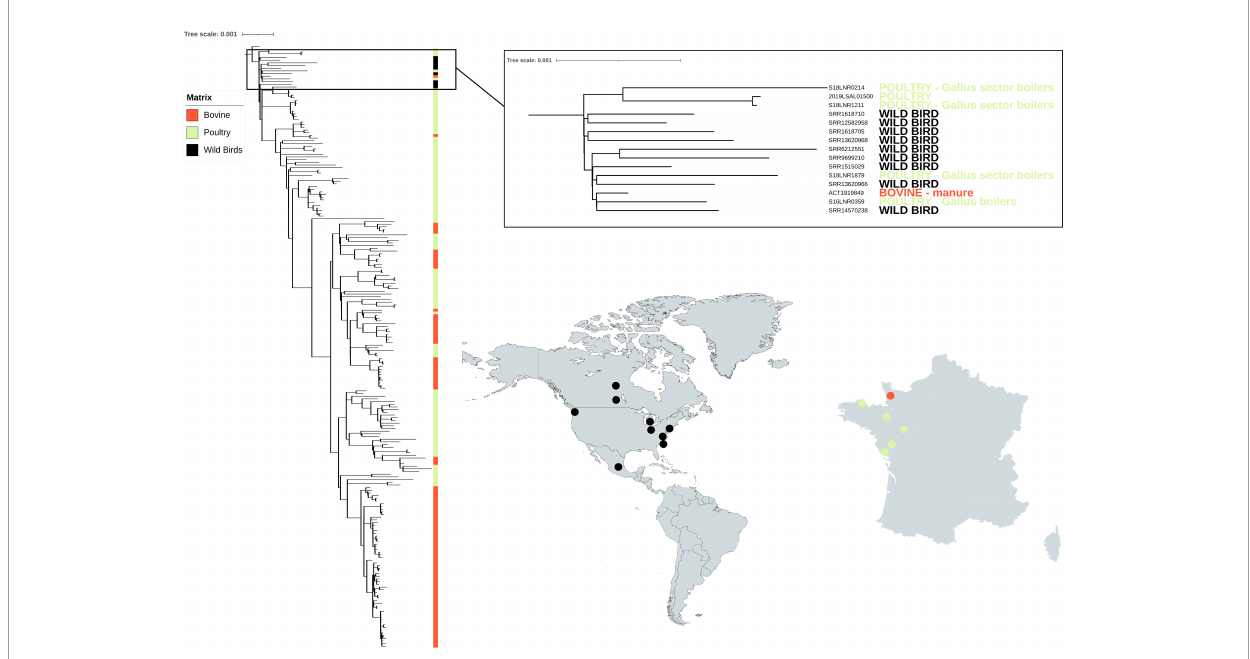
FIGURE3 Phylogenetic reconstruction based on core-genome single nucleotide polymorphism substitutions of the 214 Salmonella Mbandaka strains from France isolated from the bovine and poultry sectors and nine North American strains isolated from wild birds. The genomes ( n = 100 bovine, n = 114 poultry) were selected so that they were representative of the different groups identified by the phylogenetic analysis of the 304 bovine and avian strains (see Figure 1 ). All singletons were also included ( n = 41). The maximum likelihood criterion and the transversional model TVM + F model were applied. Salmonella Mbandaka SA20026234 was used as the reference complete